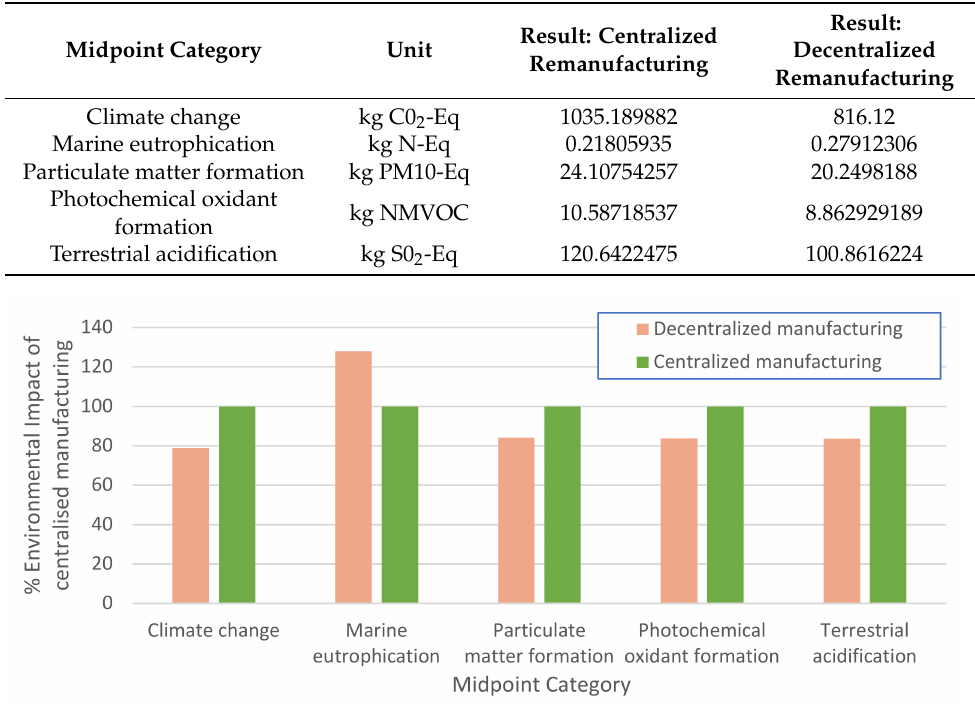
Figure 7. Total environmental impact of decentralized manufacturing compared to the central- ized manufacturing impact (centralized manufacturing environmental impact considered as the benchmark at